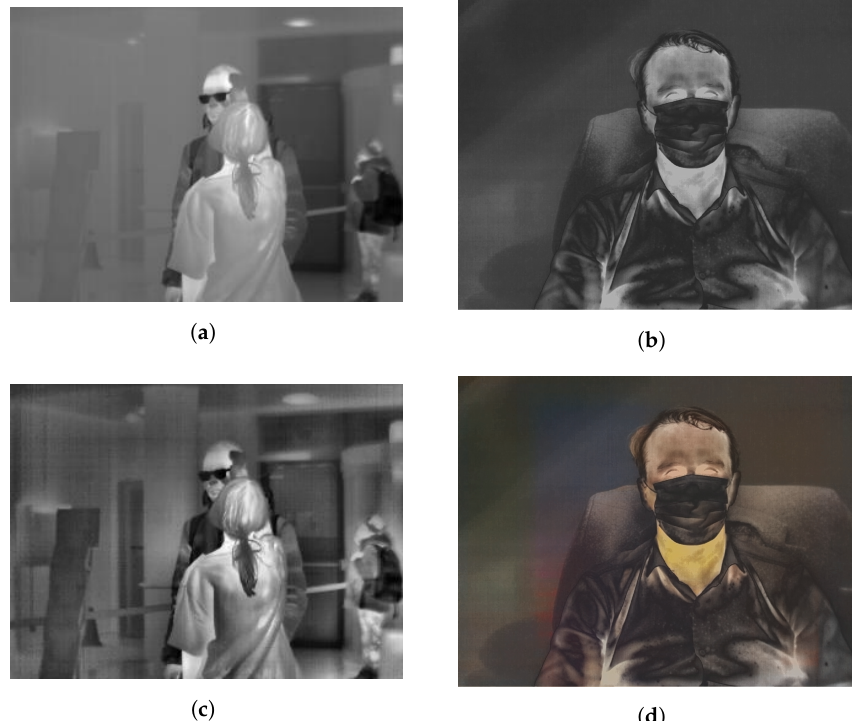
Figure 2. Example of three types of preprocessing: ( a , b ) images with normalized range of raw data, ( c ) image is image ( a ) after changing contrast using CLAHE and ( d ) image is image ( b ) after colorization.